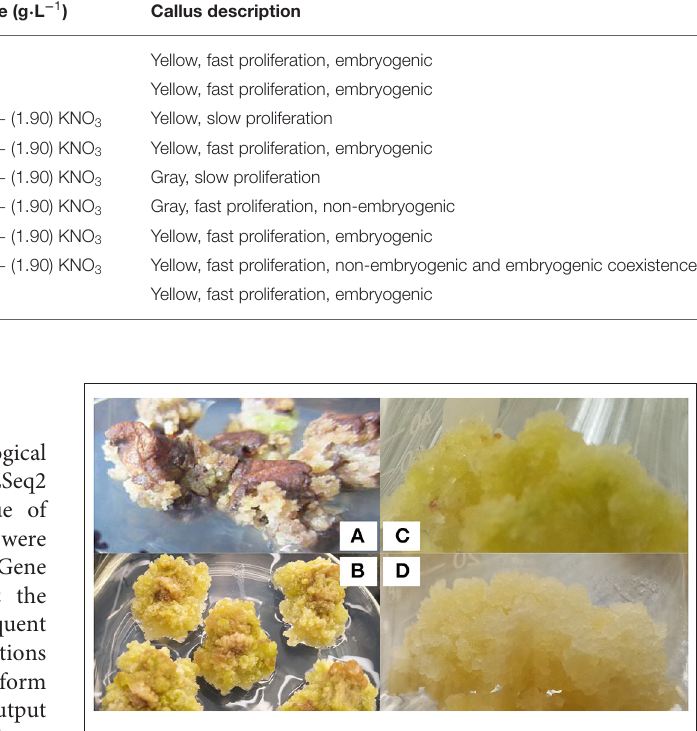
FIGURE 1 | Embryogenic callus induction in two diploid wild cotton species. (A) Callus induced from G. sturtianum , (B) callus induced from G. raimondii . (C) embryogenic callus induced from G. sturtianum , (D) embryogenic callus induced from G. raimondii .